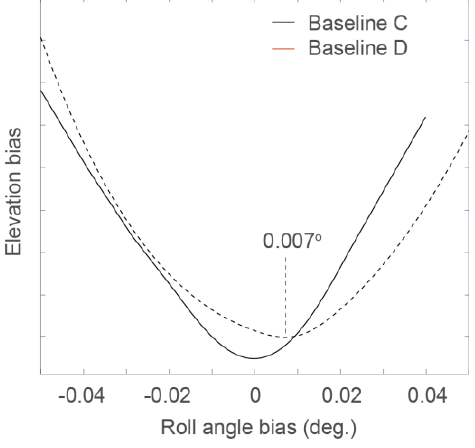
Figure 10. Elevation bias between ascending and descending CryoSat-2 passes as a function of roll angle bias. The roll bias that minimizes the dispersion of the elevation difference for Baseline-C data is found at 0.007°. The same exercise using Baseline-D data shows a minimum elevation dispersion with no significant roll angle bias. Figure taken from [12].